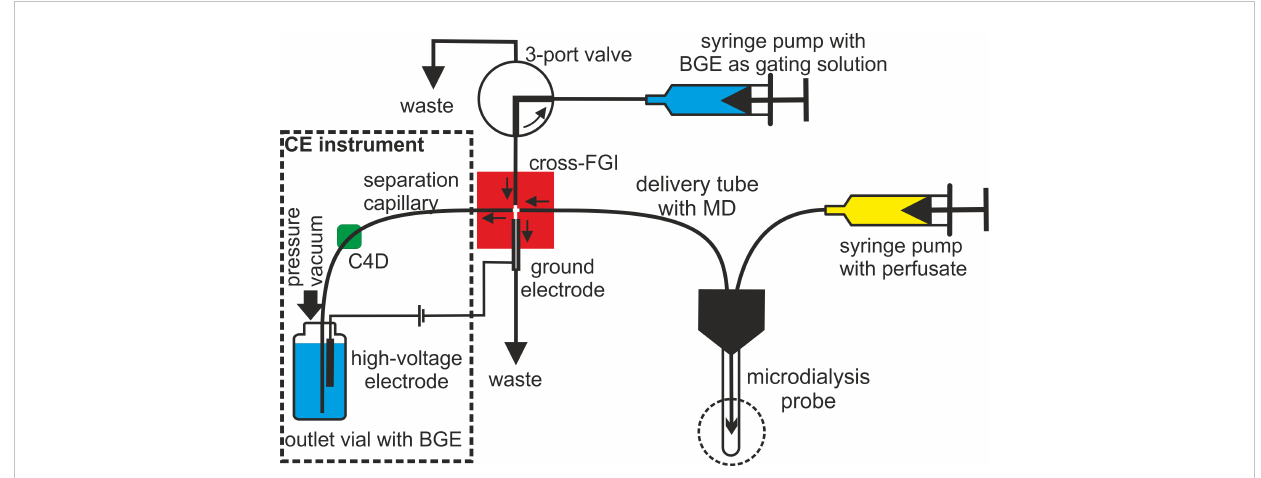
FIGURE 2 Schematic of the on-line connection of MD sampling with sequential CE analysis implemented using a cross - FGI (red). A detailed description of the FGI function is presented in the